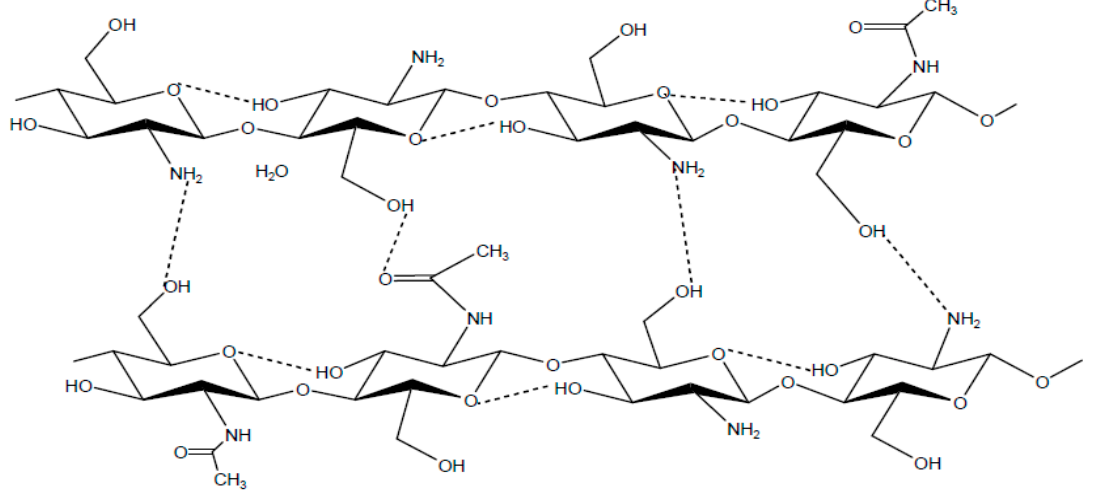
Figure 5. Crystal structure of chitosan [43].